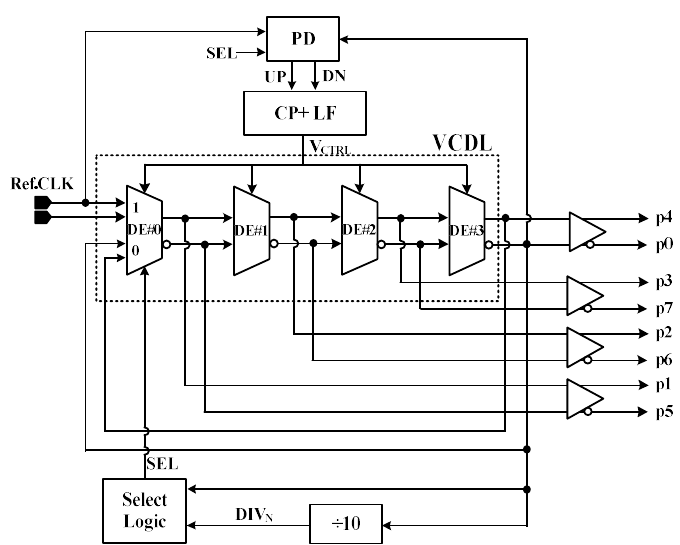
Figure 9. Block diagram of the proposed multi-phase MDLL.